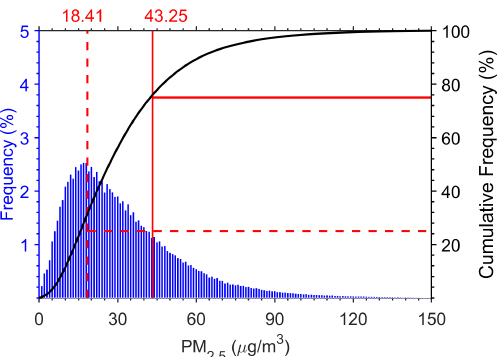
Figure 6. Mean PM 2 . 5 concentration distribution for 1205 sites over eastern China during daytime (08:00–17:00LT). Blue bars and the black line show the frequency and cumulative frequency of mean PM 2 . 5 , respectively. The mean value of the top quarter is marked by the solid red line, and the mean value of the bottom quarter is marked with the dashed red